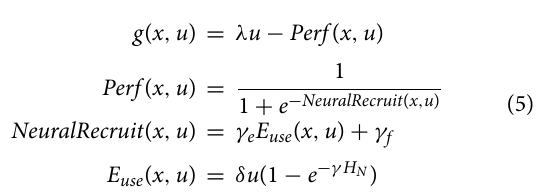
FIGURE 3 | Performance curves illustrating the relationship between resource utilization and performance. Different curves can represent either different policies/strategies for the same task or different tasks. Note that as resources are depleted, the maximum possible energy utilization rate drops (see Figure 2C ), creating the possibility of a different strategies or task being optimal based on energy dynamics alone. This provides a natural explanation for task or strategy switching as a result of